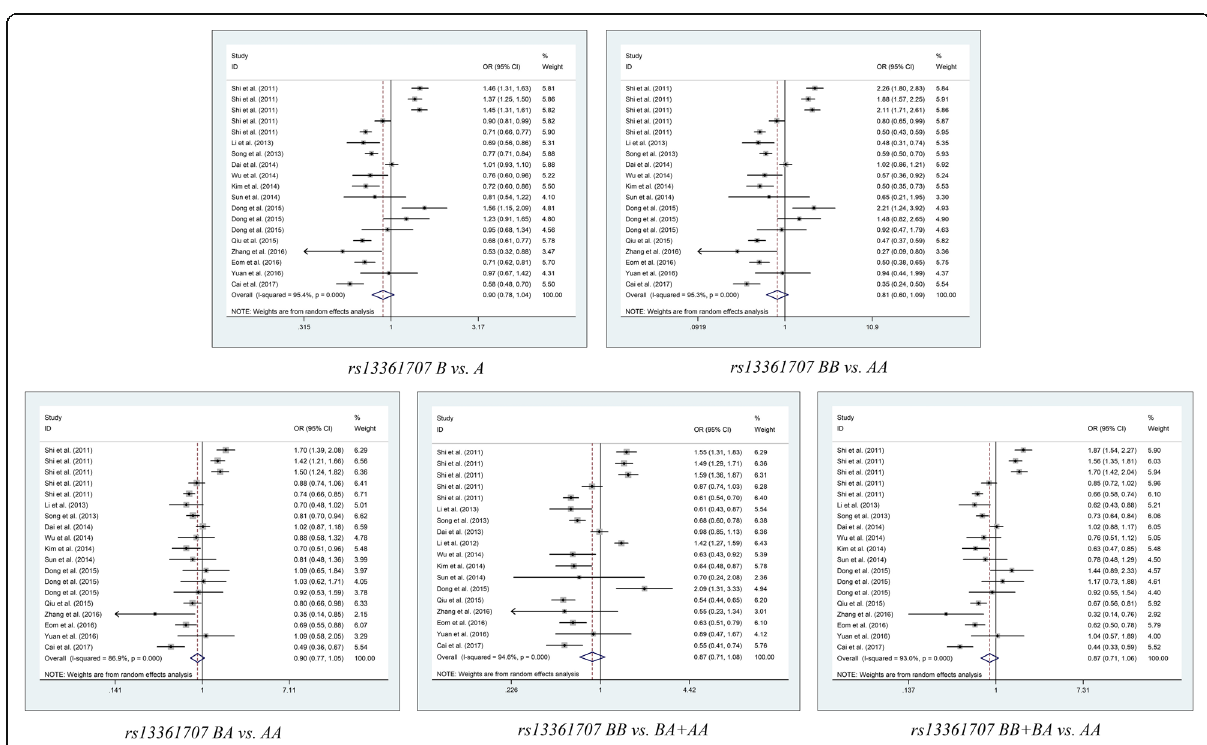
Fig. 2 Meta-analysis of the association between PRKAA1 rs10074991 polymorphism and cancer risk